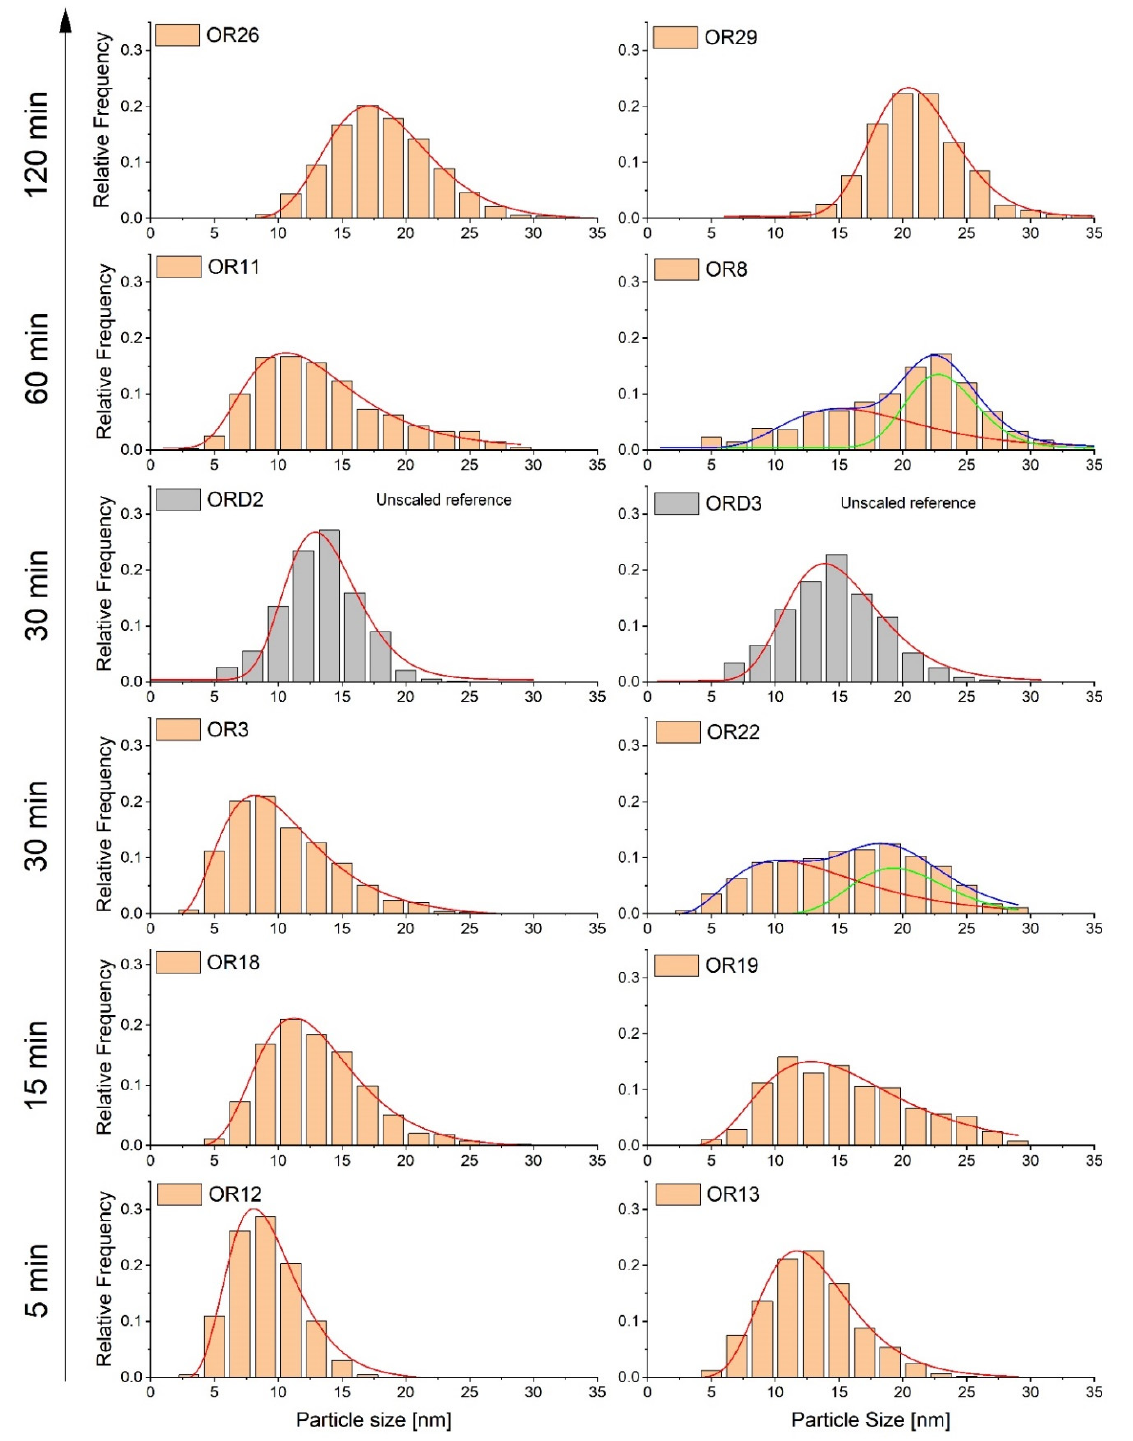
Figure 1. Evolution of TEM particle size distributions of two extreme scaled-up samples heated during different times at the highest temperature (5, 15, 30, 60, 120 min). For each boiling point time, two samples with the highest and lowest average size were chosen. The grey distribution corresponds to the unscaled samples, ORD2 and ORD3.